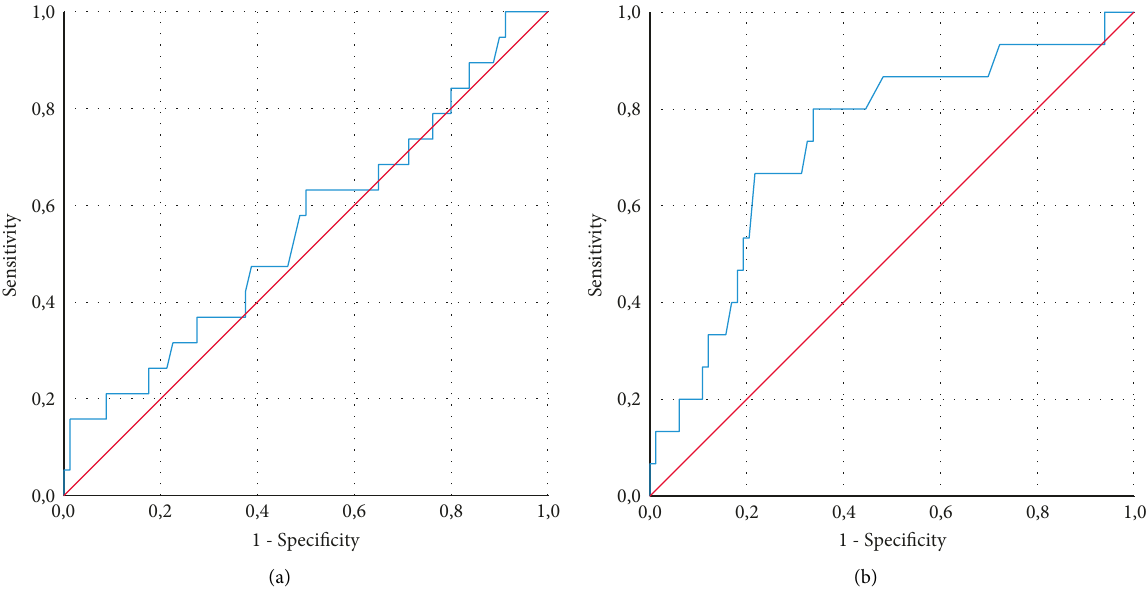
Figure 2: Receiver operating characteristic (ROC) curve. (a) Samples stored in VITPAD ® ITM; (b) samples stored in NEST ITM.